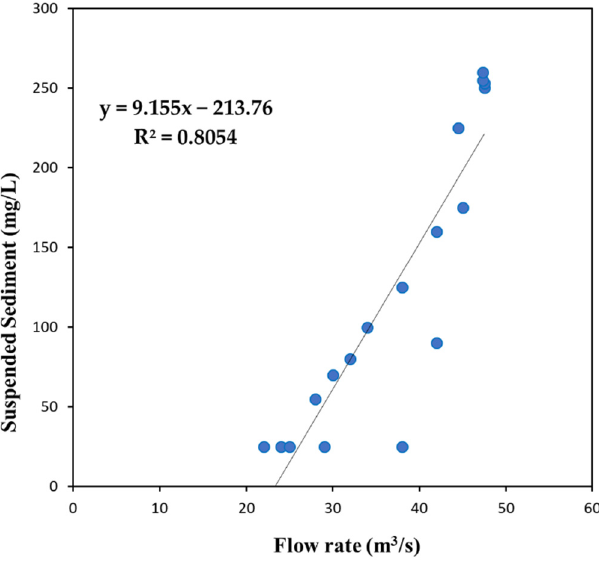
Figure 10. Discharge-suspended sediment correlation plot. Figure 11 shows the hydrological simulation results using the optimal parameter values by the MIDACO. The NSE and peak ratio (PE) were used to evaluate model perfor- mance (Equations (8) and (9)).